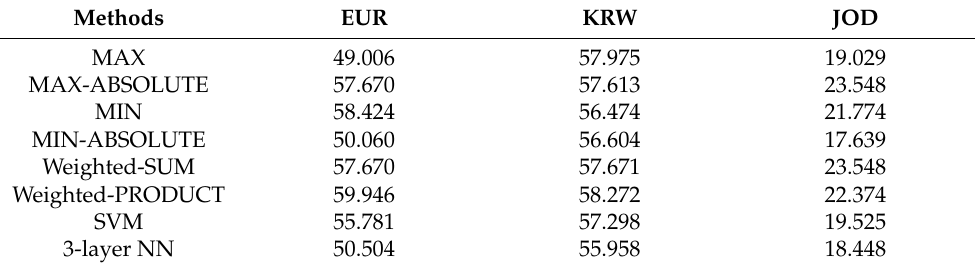
Table 8. Experimental results of training on USD and testing on the other currency types using the proposed fusion methods on two additional CNN classifiers. (Measure: mAP, unit: